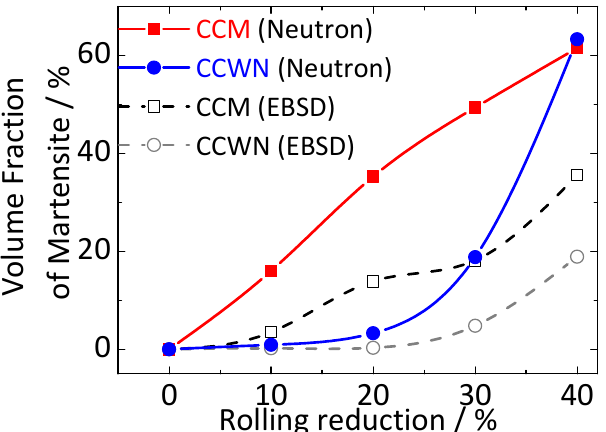
Figure 5. Relationships between the martensite phase fraction and the rolling reduction in the CCM and CCWN alloys. EBSD: Electron backscatter diffraction.